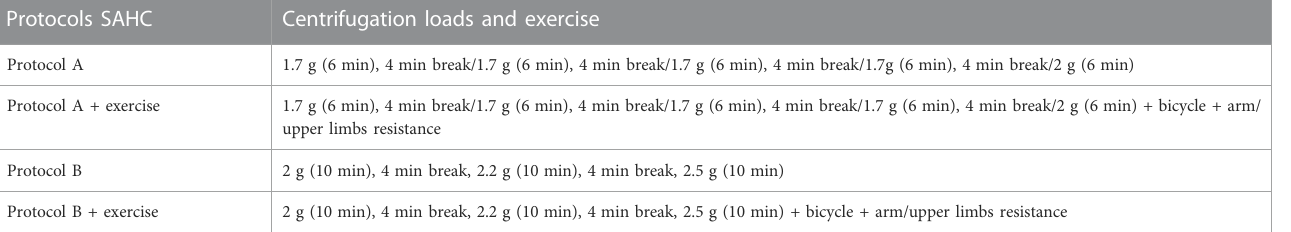
Protocol B Protocol B +